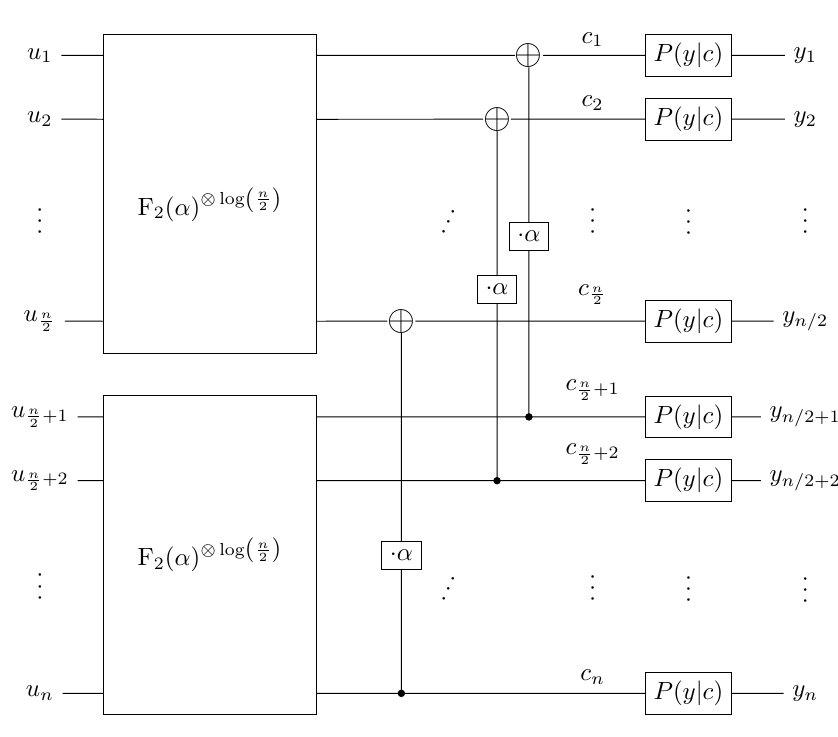
Figure 13: Polar